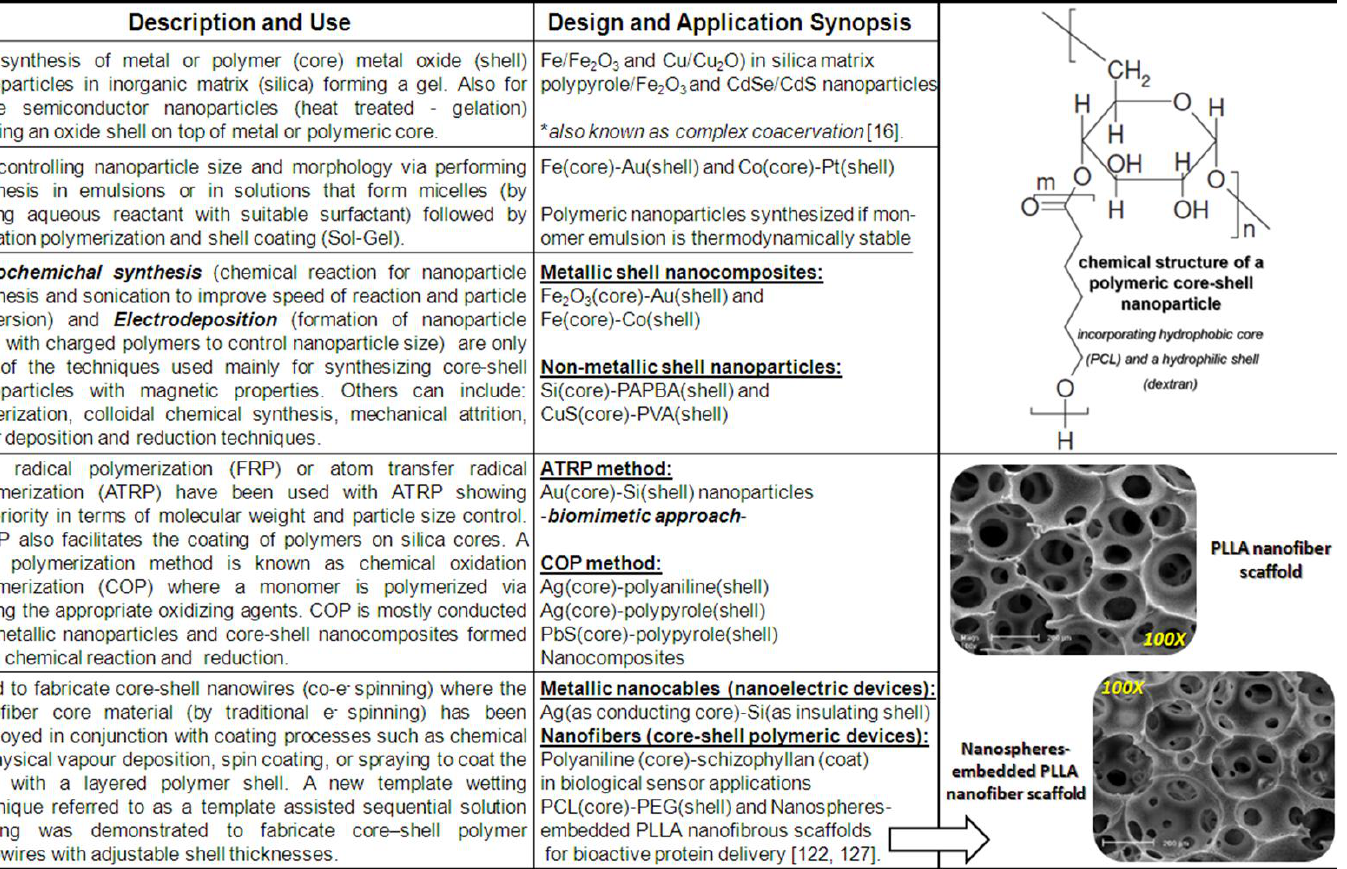
Figure 3. Selective Preparation Methods for Polymer-incorporated Core-Shell